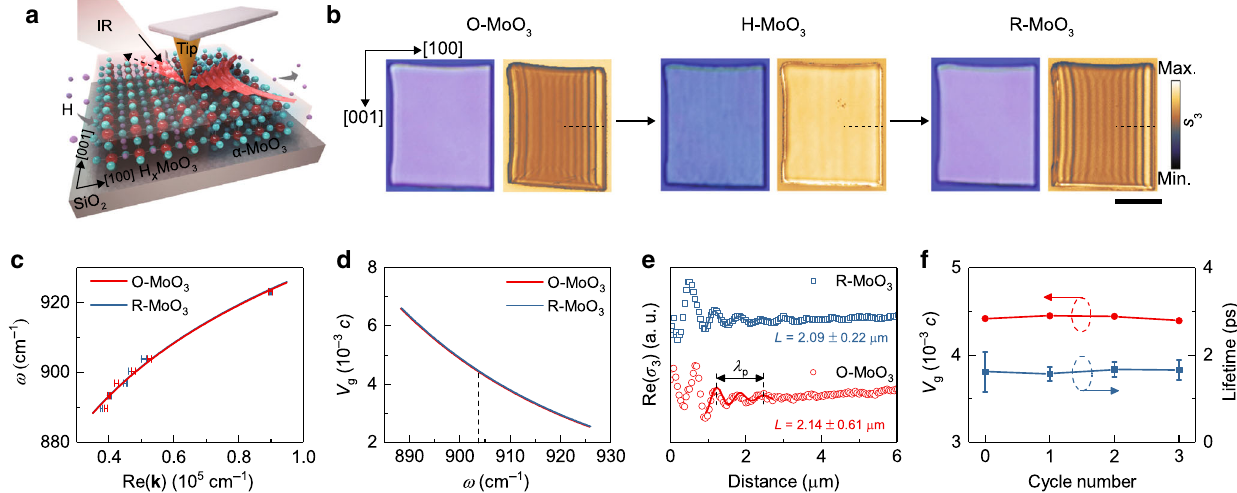
Fig. 2 Reversible switching of PhPs in the L-RB of α -MoO 3 . a Schematic of the s-SNOM measurement and PhP propagation in a typical H-MoO 3 / α -MoO 3 in-plane heterostructure. b Optical micrographs and s-SNOM amplitude images (890 cm − 1 ) of a MoO 3 fl ake on a SiO 2 /Si substrate before intercalation, after intercalation (10 s) and after deintercalation. Scale bar = 5 μ m. c PhP dispersion data and fi tting results (solid lines) along the [100] direction. The error bars de fi ne the 95% con fi dence intervals. d Group velocities of PhPs in original and recovered fl akes extracted from the fi tting results in c . e Extracted real-part near- fi eld line traces and fi tting curves (solid lines) at 903 cm − 1 . f Comparison of the group velocities and lifetimes of PhPs (903 cm − 1 ) after three reversible intercalation cycles. The error bars of lifetimes were calculated based on the errors of propagation lengths originating from the standard deviation of fi tting.